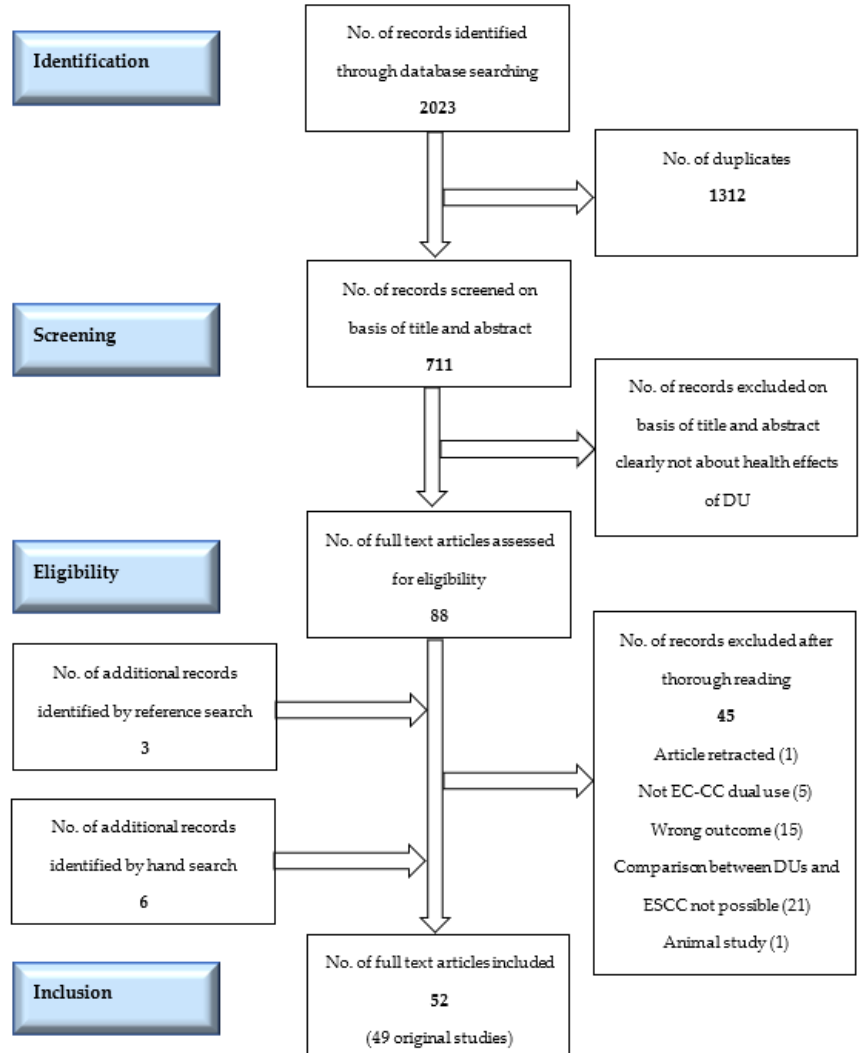
Figure 1. The PRISMA flow-chart of the search and inclusion of the papers in the systematic review. DUs= dual users. CC= conventional cigarettes. EC= e-cigarettes. ESCC = exclusive smokers of con- ventional cigarettes.